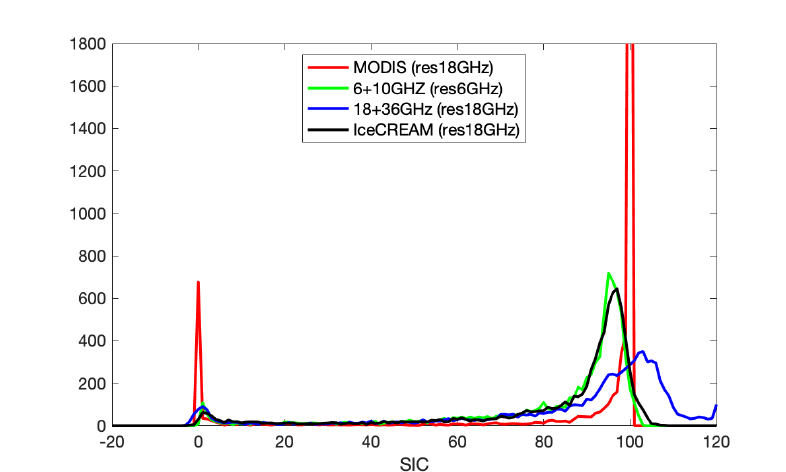
Figure 7. For the 20 April 2018 scene, the histograms of the SIC for MODIS at 18 GHz resolution in red, for our 6+10GHz AMSR2 algorithm in green, for our 18+36GHz AMSR2 algorithm in blue, and for the IceCREAM retrieval (all channel algorithm in black). The pixels that are cloud contaminated at more than 50% are excluded, as estimated by MODIS.